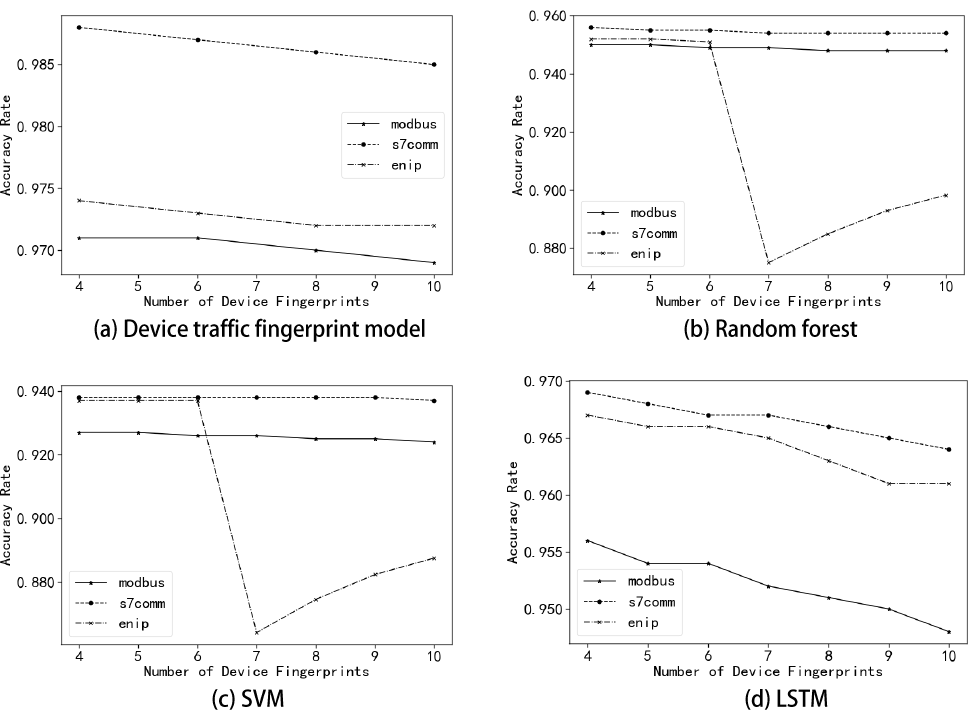
Figure 12. Accuracy curves of the four